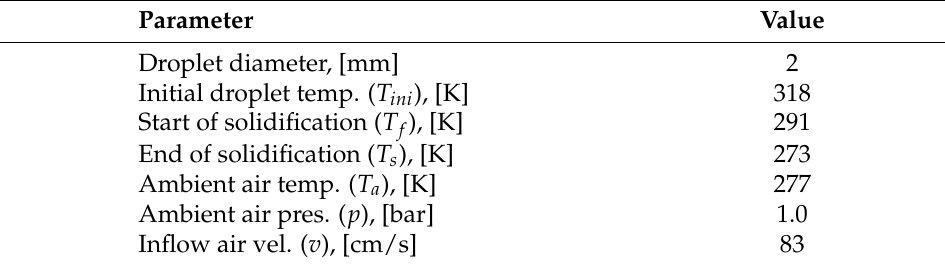
Table 2. Data used in the model validation for CB